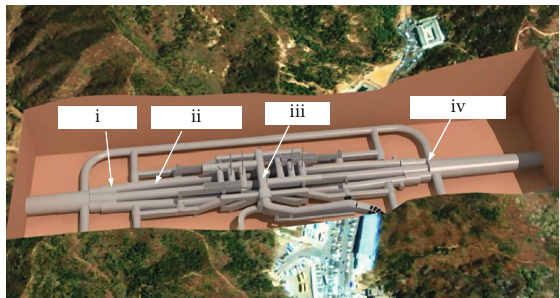
Figure 7: Structure diagram of Badaling Great Wall station. (i) Three-connected-arch, (ii) three-hole separation section, (iii) stop layer, and (iv) large span transition